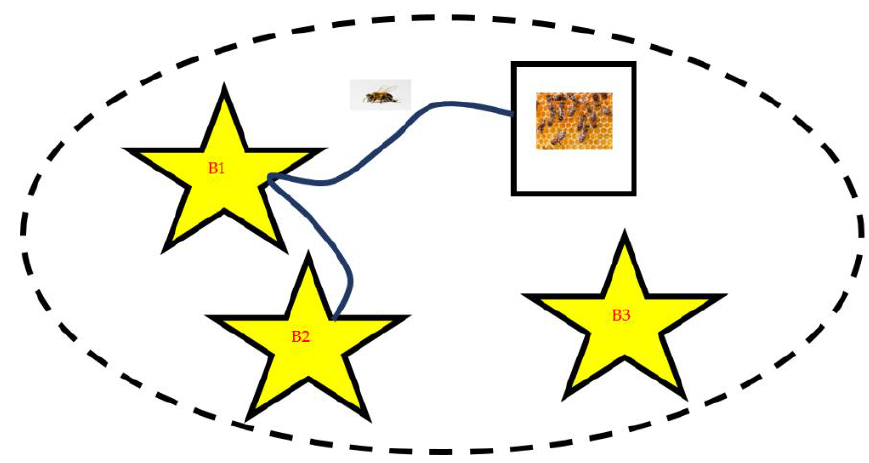
Figure 6. Working flow of ABC.